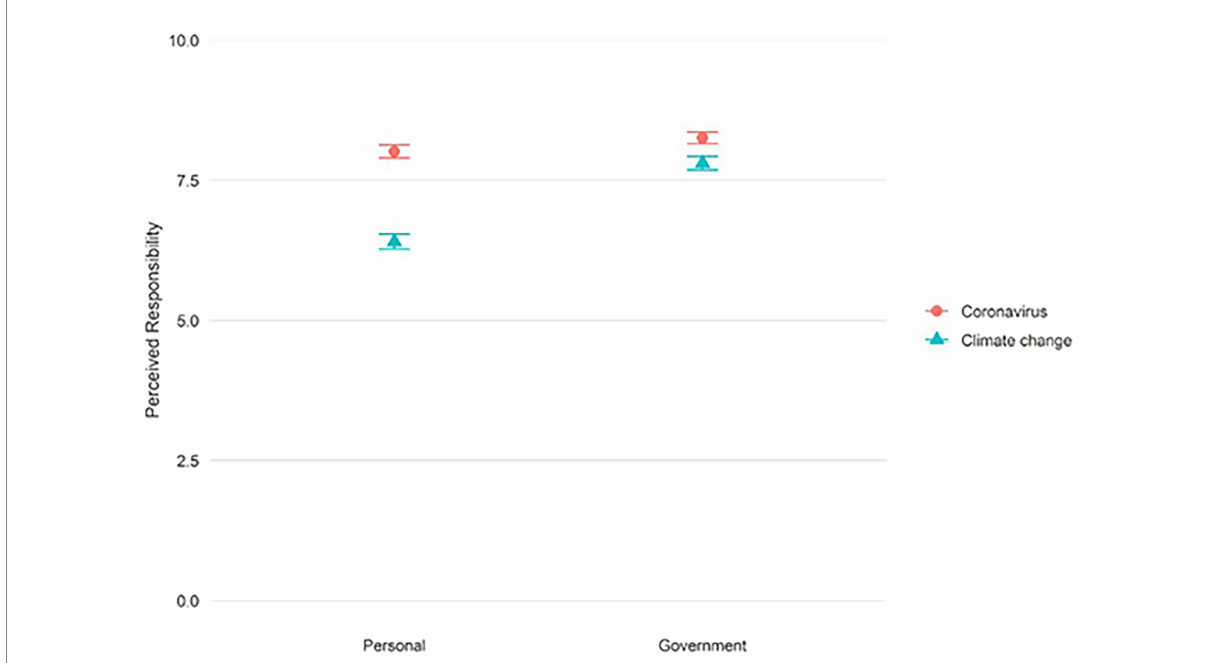
FIGURE 1 Mean scores for personal responsibility and government responsibility to try to prevent coronavirus from spreading (circle) and climate change from worsening (triangle). Error bars reflect the 95% confidence intervals (also see Supplementary Table